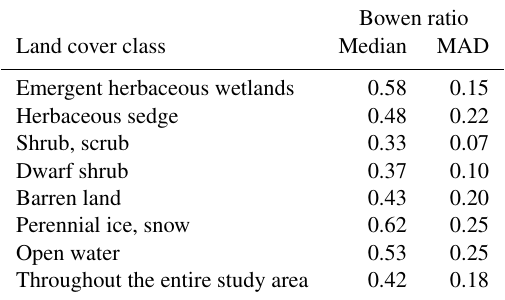
Table 5. Median Bowen ratio ( β ) values and median absolute devi- ation (MAD) of β for different NLCD land cover classes, estimated from β map (Fig.